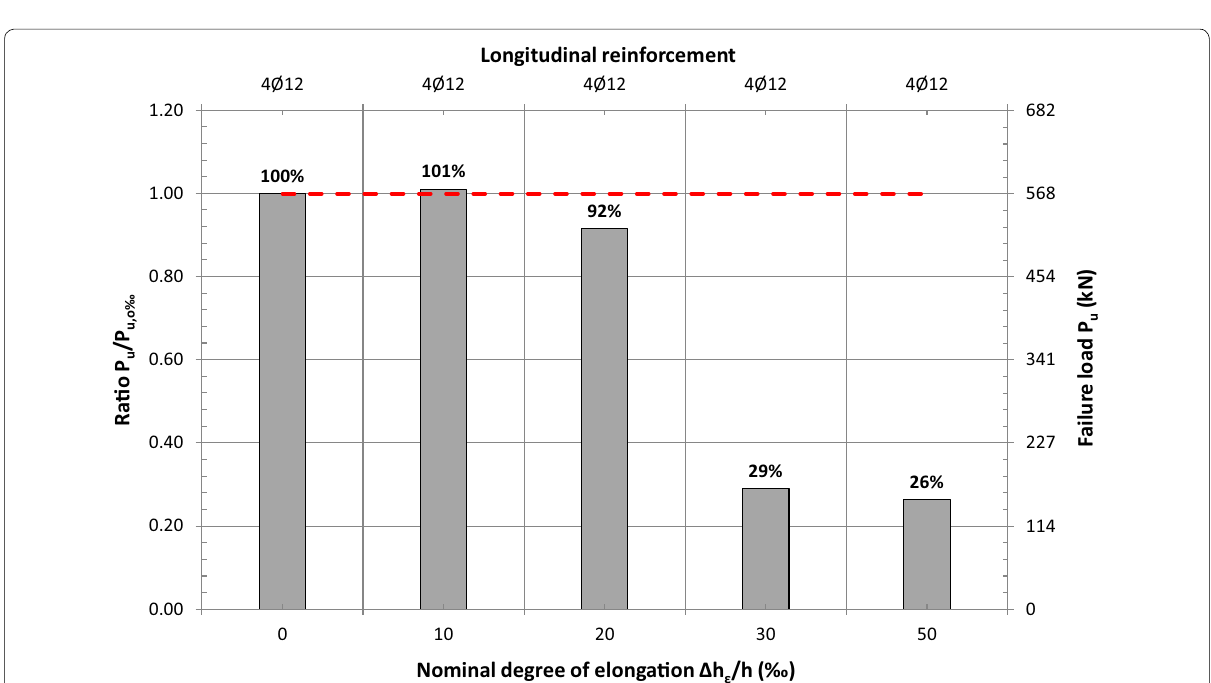
Fig. 11 Column diagram of ultimate failure load as a percentage of the failure load of the “initial” specimen regarding the degree of